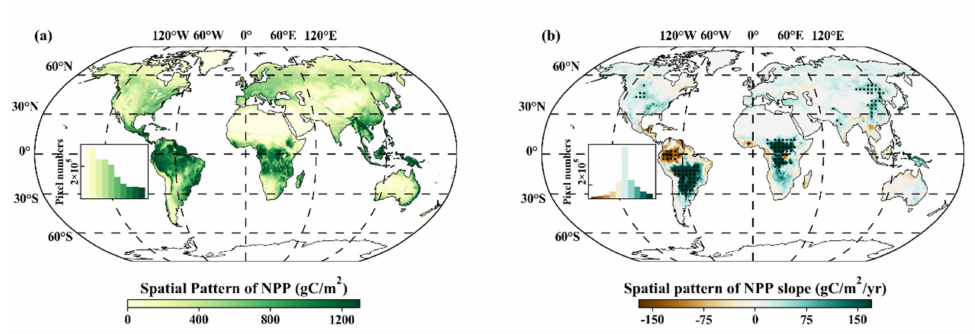
Figure 3. Spatial pattern of global NPP ( a ) and its trend ( b ) from 2001 to 2020. The frequency of the uncertainty value is in the left of each subfigure. The regions with black dots in ( b ) indicate that the trend is statistically significant at the 0.05